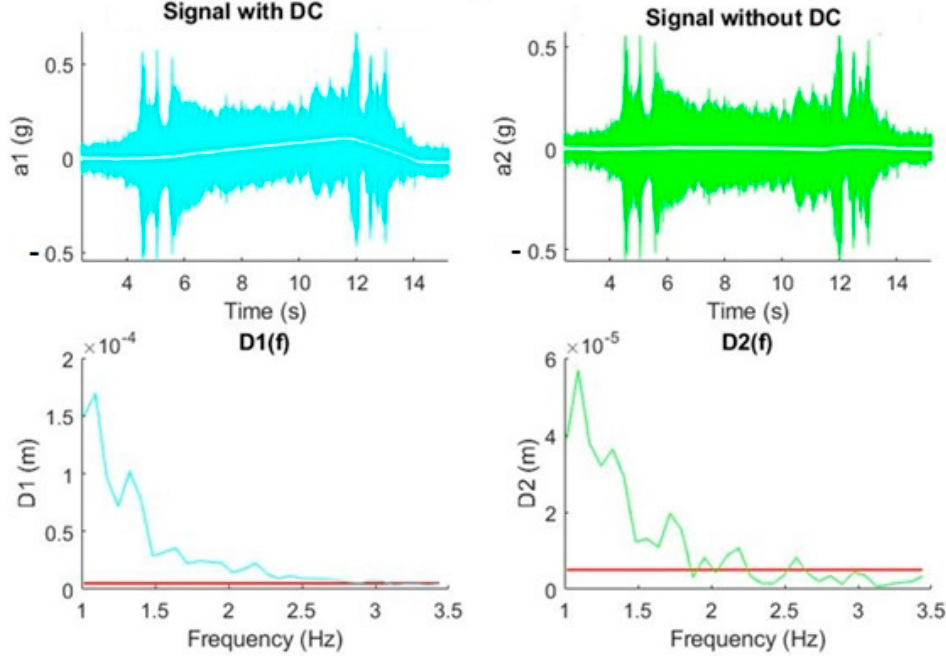
Figure 10. DC removal effect on a real signal (declination movement from 40° to 0°). The red line in the graphs establishes the maximum value of the displacement.